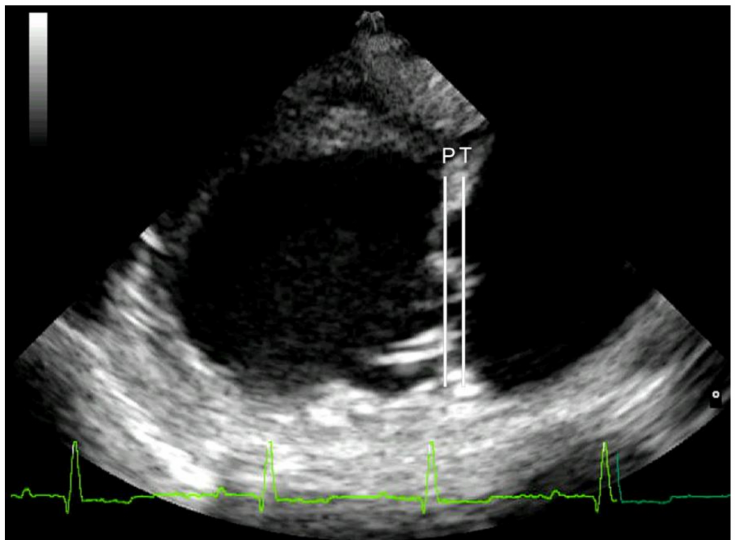
Figure 1. Right parasternal long-axis four-chamber view of a Cavalier King Charles Spaniel (CKCS) a ff ected by myxomatous mitral valve disease (MMVD) in American College of Veterinary Internal Medicine (ACVIM) class D; severe mitral valve prolapse was assessed by the protrusion of one or both leaflets over line T. The arrows outline the severity of mitral valve prolapse and the a ff ected leaflet. Line P is drawn from the hinge point of the anterior leaflet to the hinge point of the posterior leaflet. Line T is drawn from the middle of the elliptical echogenic area at the lower part of the atrial septum to the atrioventricular junction, i.e., the junction between the left ventricular wall / annulus fibrosis and the left atrial